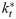
Real-time APE sensitivity to increasing transmission.We simulate 103 independent epi-curves under renewal models with sharply (A) increasing and (B) recovering epidemics. Top graphs give the true (green) and predicted (blue) incidence ranges, the middle ones provide estimates of Rs under the final kt* and the bottom graphs illustrate how successive ks* choices from APE vary across time and are sensitive to real-time elevations in transmission.